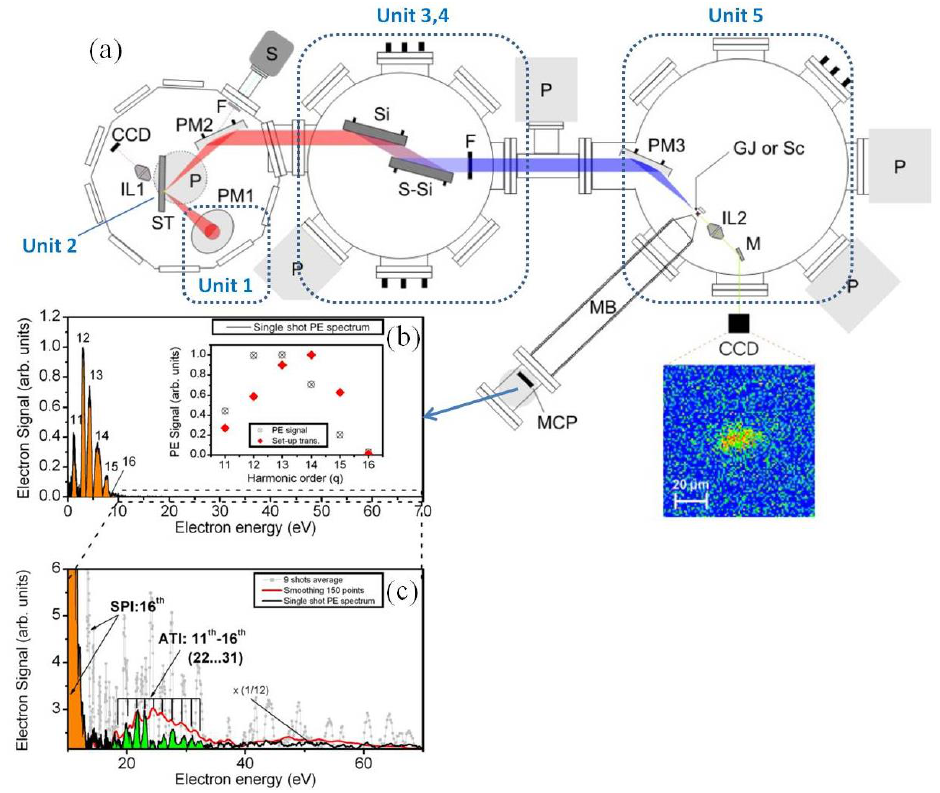
Figure 9. ( a ) Schematic diagram of the experimental setup. PM1, 2, 3: parabolic mirrors; ST: solid target; IL1, 2: imaging systems; F: filters; S: XUV flat field spectrometer; S-Si, Si: silicon plates; GJ: Ar gas jet; Sc: the scintillator used for the imaging of the XUV focus (the image in the inset); MB: 1.5 m long magnetic bottle; MCP: microchannel plates; M: mirrors; P: turbo pumps; ( b ) Single-photon photoelectron spectrum of Ar (black line). The ionizing radiation consists of harmonic 11th–16th. The measured PE (crossed circles) and calculated overall spectral transmission (red rhombs) of the setup is shown in the inset; ( c ) Two-XUV-photon ATI photoelectron spectrum of Ar. The black line filled in green shows a single-shot trace, the gray dotted line is an average of nine shots and the red line is obtained from the nine shots average (gray dotted line) after a 150 points moving average is performed. The orange and green shaded areas depict the SPI and ATI signals, respectively. Figure from Ref. [92].